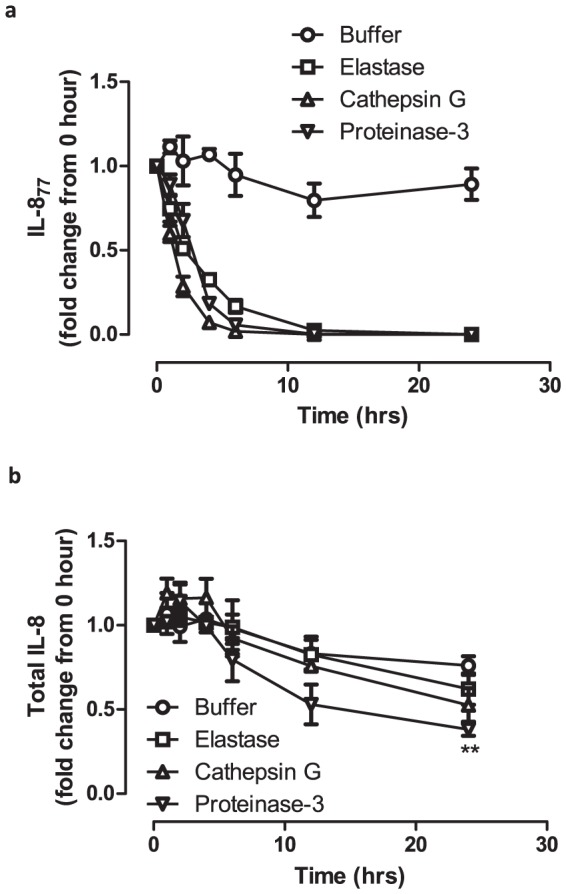
Time-course of conversion of IL-877 by purified proteases.(a) Fold change in concentration of IL-877 and (b) total IL-8 on incubation with by purified neutrophil proteases at different time-points. Time (hours) is represented on the x-axis while the fold-change in concentration (compared to concentration at “0-hour”) is represented on the y-axis. Points plotted are means (± SEM) of three independent experiments, each measured by ELISA in duplicate. Differences in concentration was compared by two-way ANOVA with Bonferroni's correction. (** = p<0.01; p-values for figure 4a are mentioned in the text)